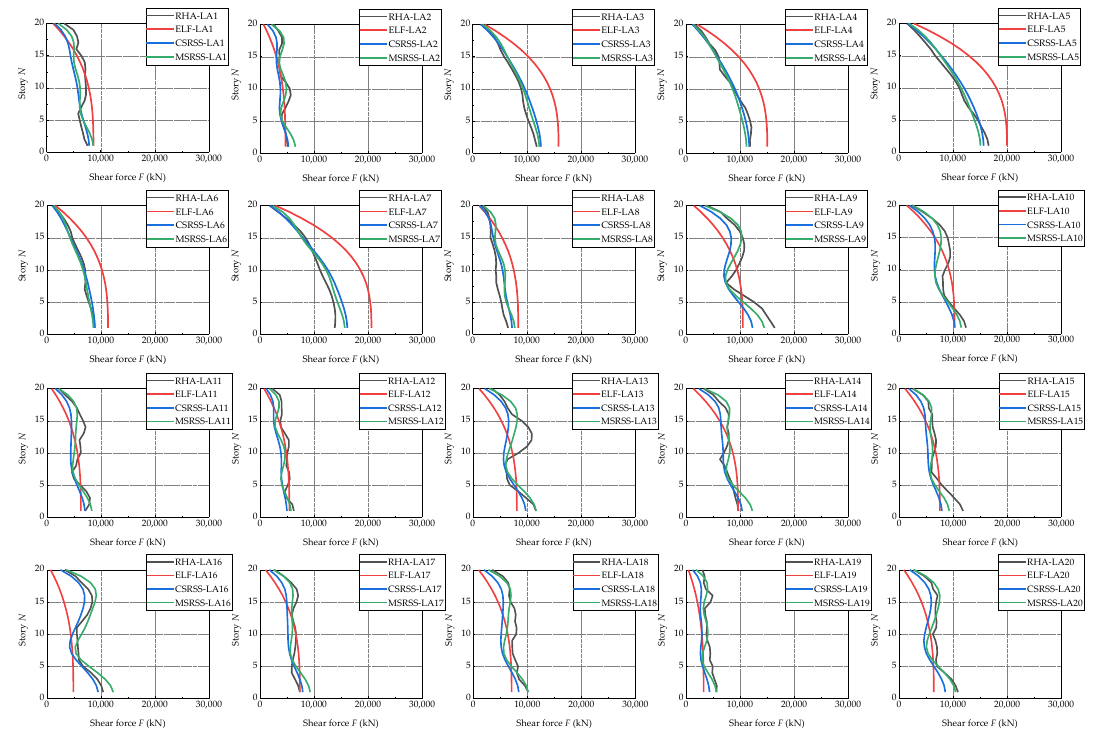
Figure 7. Shear force demands of the considered benchmark frame from the ELF, RSA, and RHA.